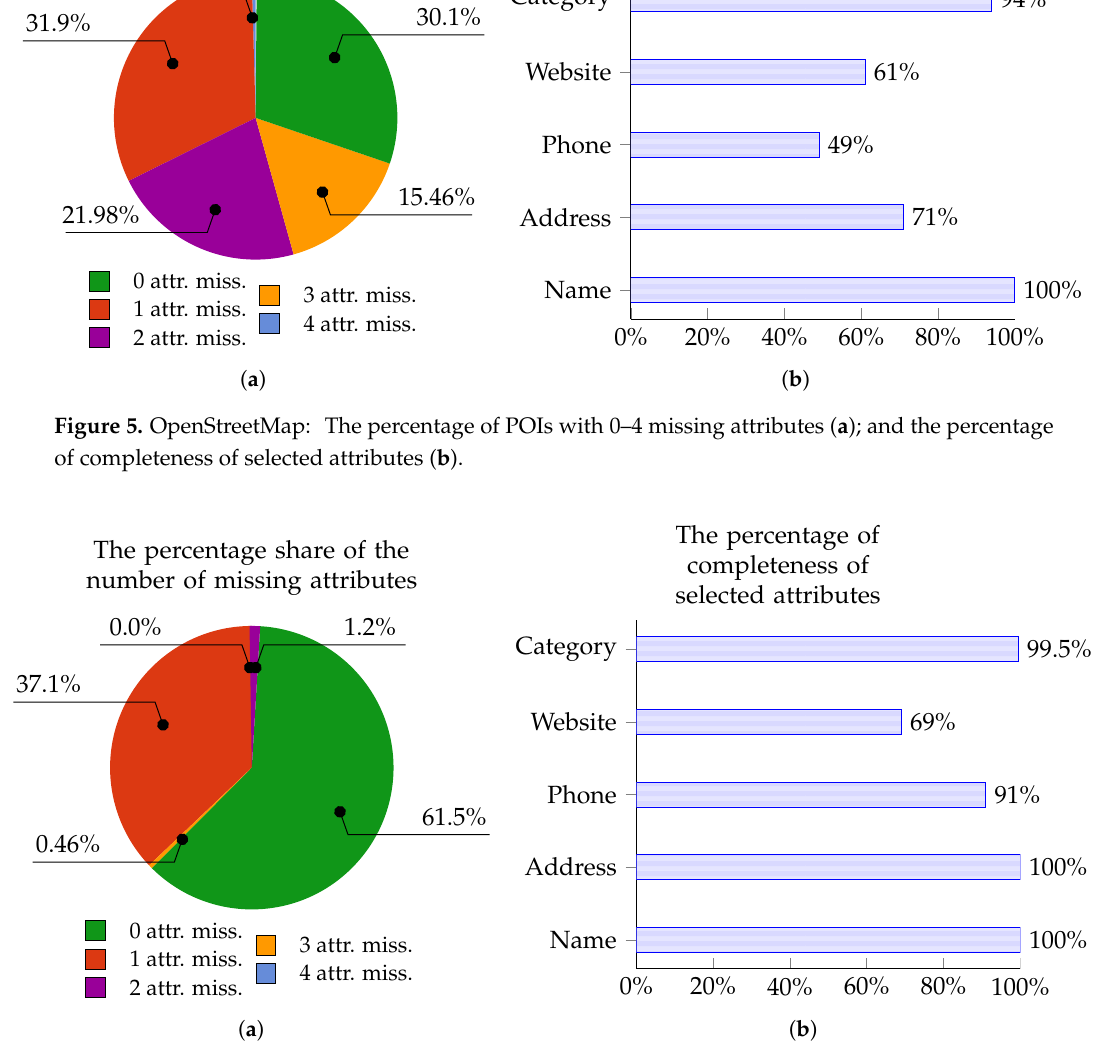
Figure 6. Foursquare: The percentage of POIs with 0–4 missing attributes ( a ); and the percentage of completeness of selected attributes ( b